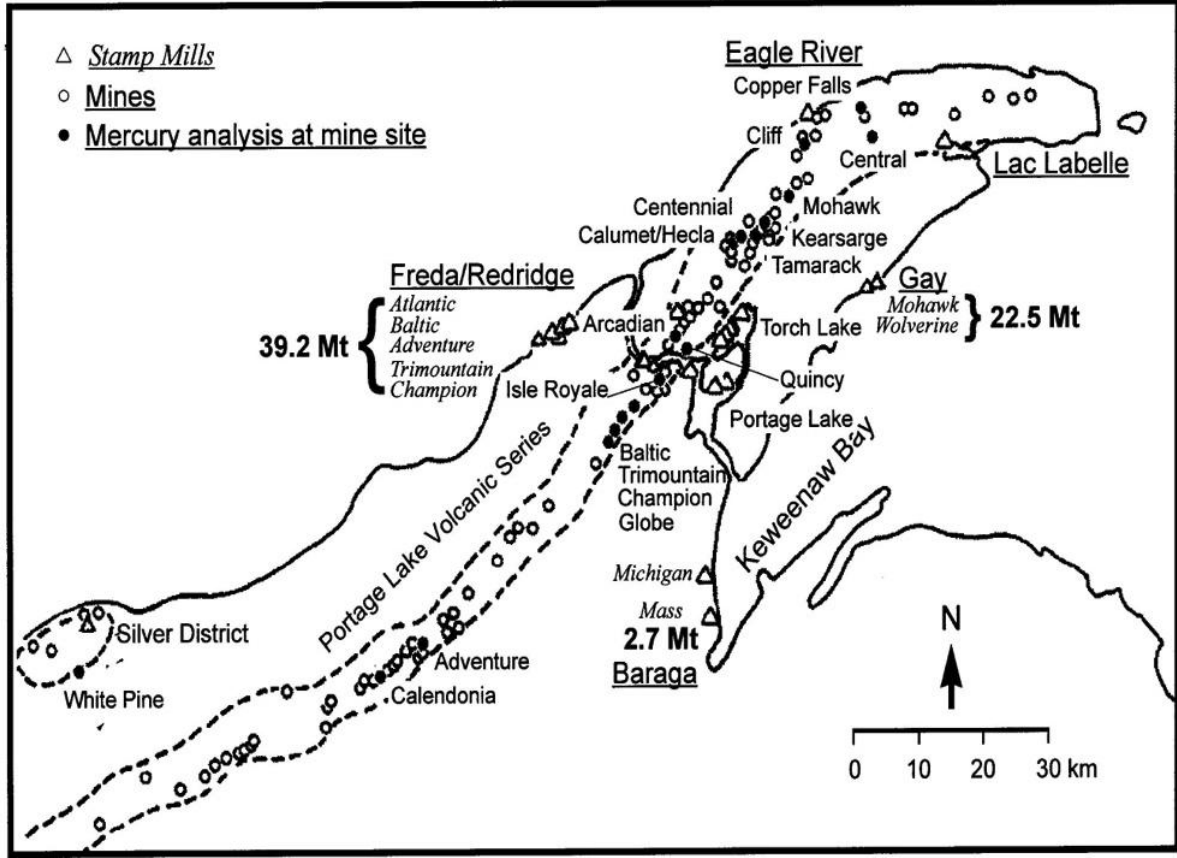
Figure 2. Native copper and silver mine era locations along the Keweenaw Peninsula, Upper Peninsula, of Michigan. The amount of tailings discharged (Mt, million metric tons) from larger, coastline “stamp” mills (1895–1947) are shown. The locations of mines (circles) and mills (hollow triangles) are plotted along the Portage Lake Volcanic Series and on the coast (modified from Kerfoot et al. ,